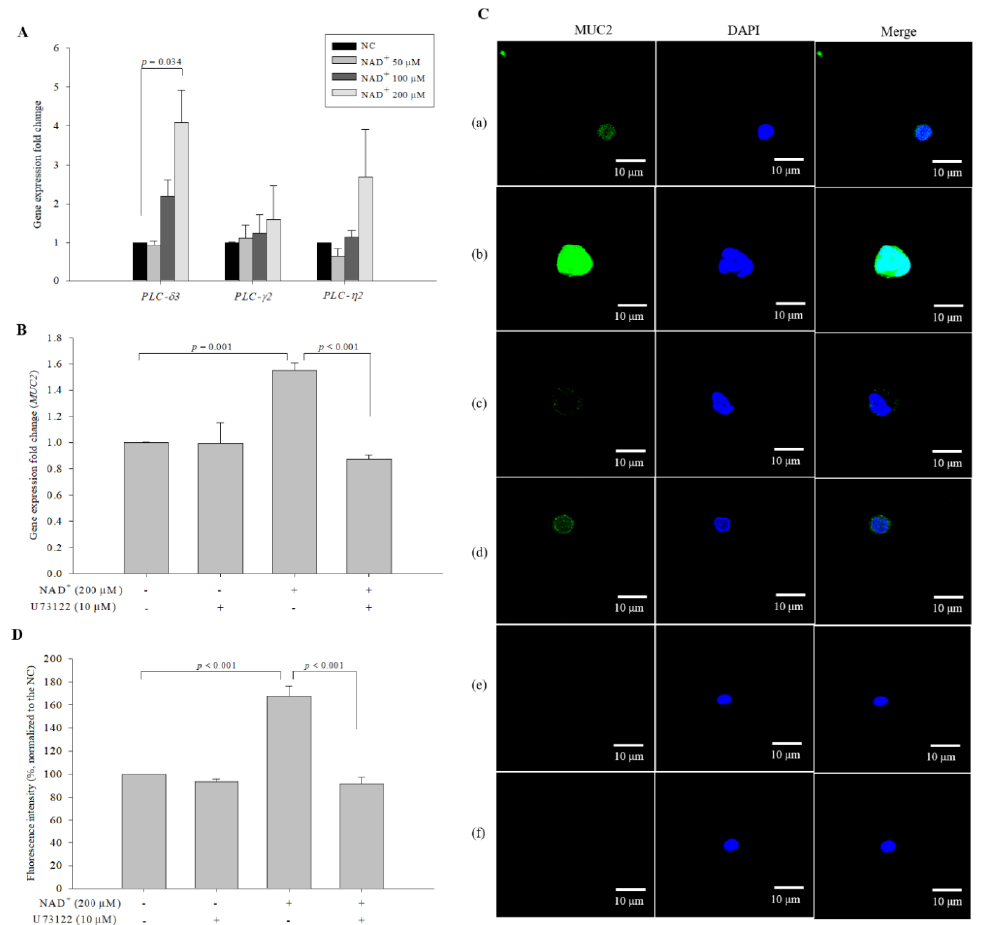
Figure 5. PLC-δ3 involvement in the pathway of NAD + -mediated stimulation of MUC2 expression. ( A ) The expression levels of PLC variants were detected by qPCR. U73122 was used to inhibit PLC-δ, and MUC2 expression was observed at the gene level ( B ) and at the protein level using ICC (magnification 600×) (C). To clarify that the secondary antibodies were not affected the generation of a fluorescence signal, the preparations of the negative control and 200 µM NAD + -treated cells were created by omitting the primary antibody. ( a ) Negative control, ( b ) 200 µM NAD + , ( c ) 10 μM U73122, ( d ) 200 µM NAD + and 10 μM U73122, ( e ) negative control without the primary antibody, ( f ) 200 µM NAD + without the primary antibody. The fluorescence intensity was quantified ( D ). The data are expressed as the mean ± SD of three independent experiments performed in triplicate. The symbols + and – indicate chemical treatment and non-treatment, respectively.